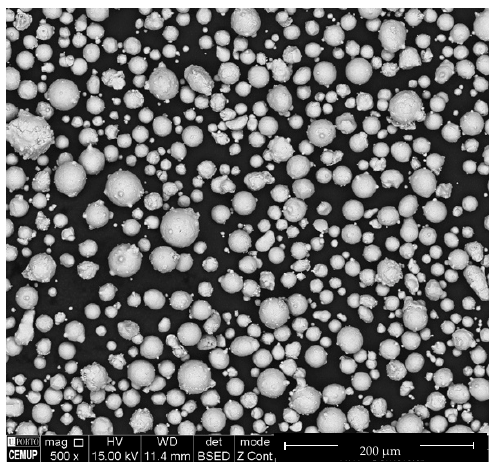
Figure 1. X-ray diffractogram of prealloyed NiTi powder containing ( a ) NiTi and NiTi 2 , ( b ) Ni, and ( c ) Ni after magnetic separation.